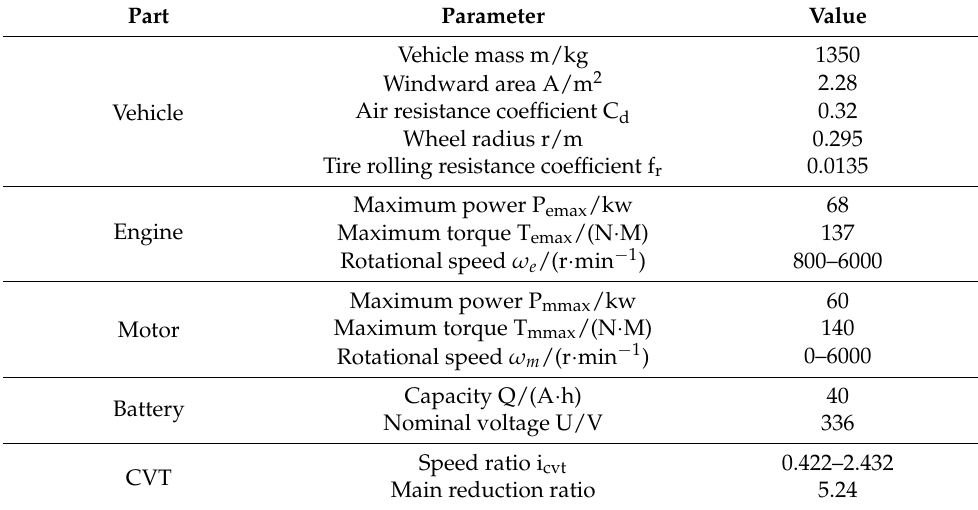
Table 1. Main parameters of hybrid vehicles.